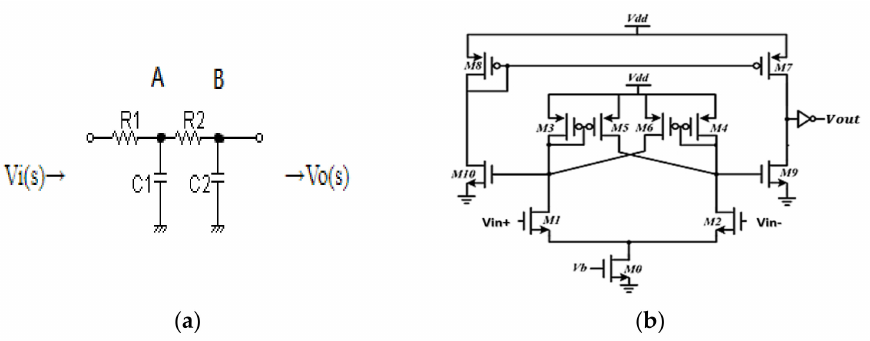
Figure 11. ( a ) The two cascading resistor-capacitor (RC) filters; ( b ) the continuous-time comparator